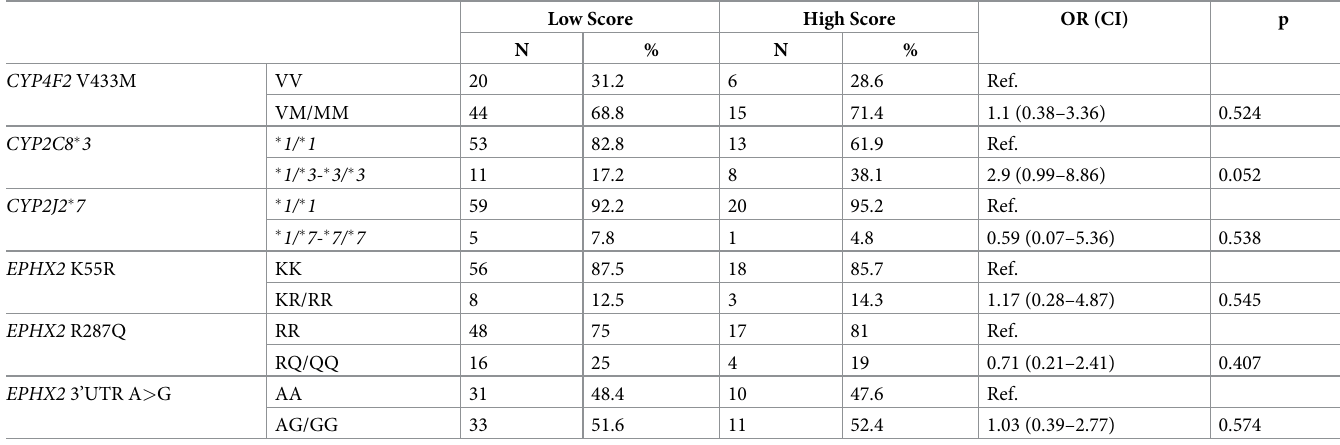
Table 3. Crude analyses for the association between polymorphisms in CYP and EPHX2 genes of the donor and pretransplant renal biopsy scores.